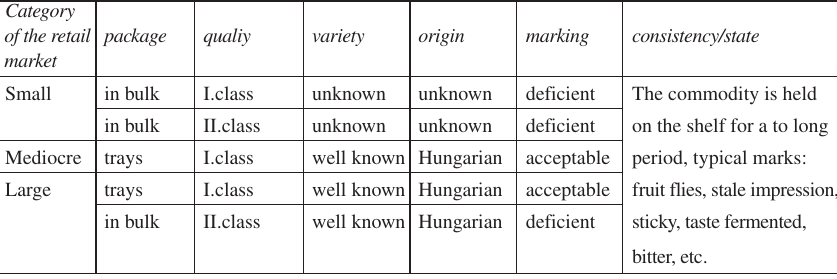
Table 1. Characteristic qualities of sour cherries packed for fresh consumption in the retail markets